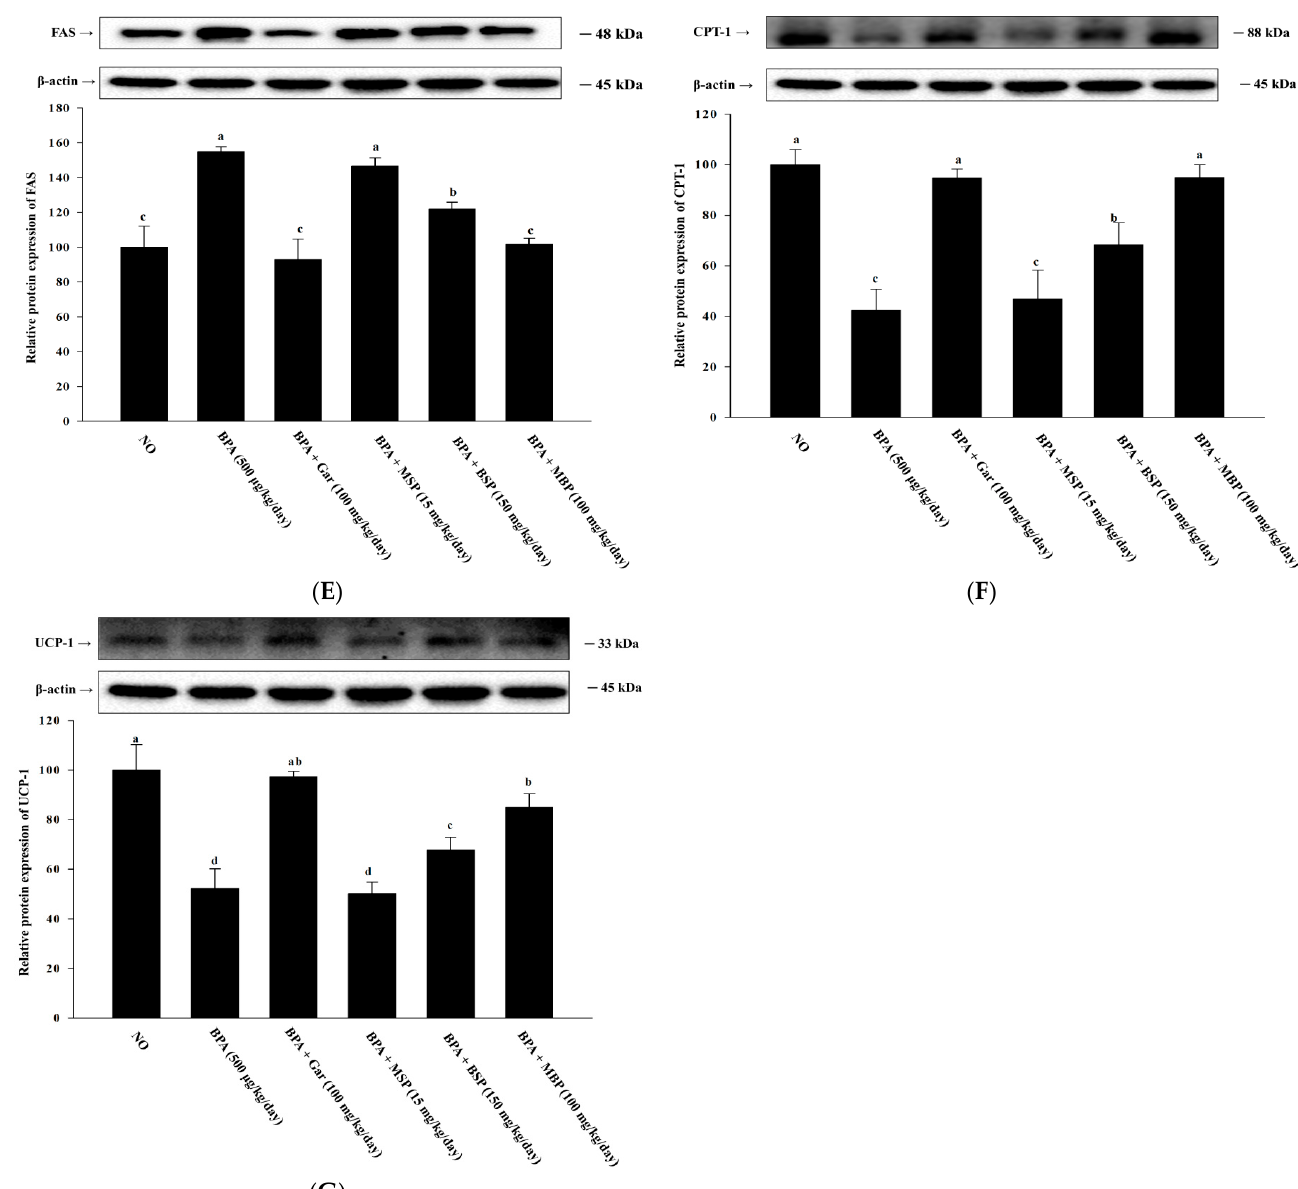
Figure 5. Effects of MBP, BSP, and MSP on the expression of lipid metabolism-related proteins (PPAR- γ ( A ), C/EBP- α ( B ), aP2 ( C ), SREBP-1C ( D ), FAS ( E ), CPT-1 ( F ), UCP-1 ( G )) in epididymal adipose tissue. Each value is expressed as mean ± SD of three independent experiments. Different lower letters on the bars indicate statistical differences at p < 0.05.